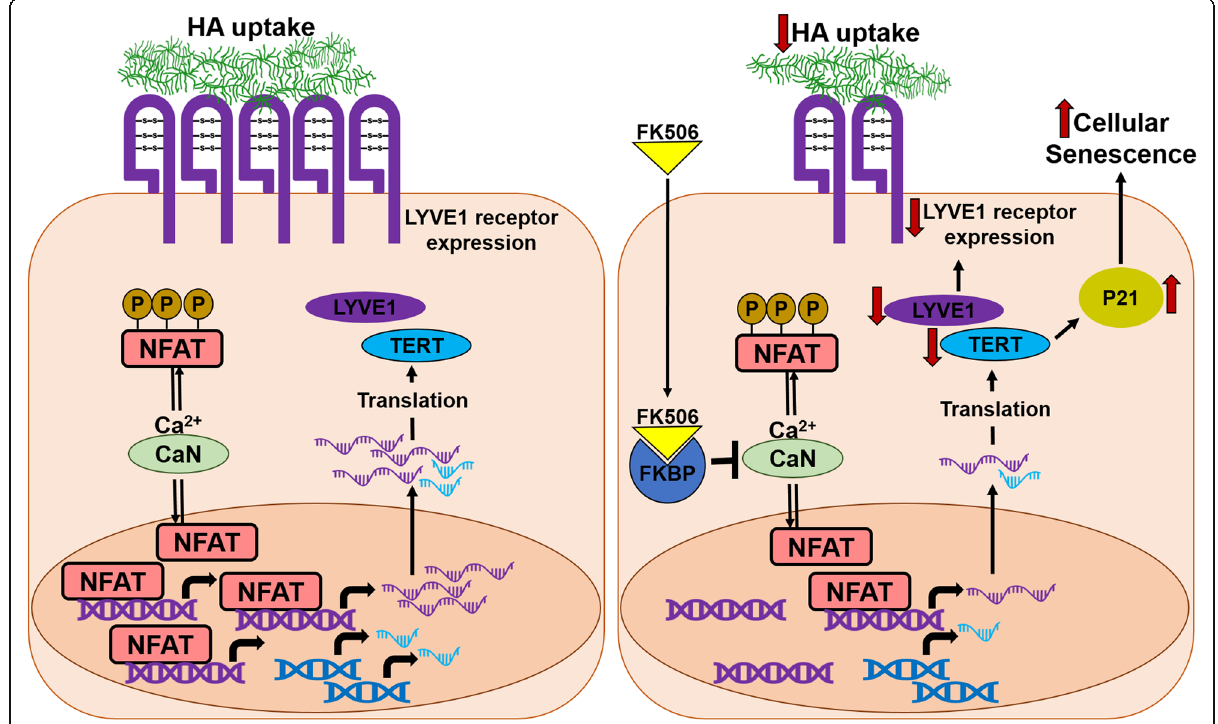
Fig. 7 Schematic representation of FK506-induced lymphatic dysfunction. Calcineurin dephosphorylates NFAT proteins and induces translocation of NFAT into the nucleus (Hogan et al., 2003). This leads to increased transcription of NFAT target gene. Our study demonstrated that LYVE-1 is one of the target gene regulated by NFAT. This increases LVYE-1 receptor expression in lymphatic endothelial cells (LEC), where LYVE-1 plays an important role in HA-uptake and clearance. In LEC in vitro, FK506, a calcineurin inhibitor, prevents the nuclear translocation of NFAT, resulting in reduced LYVE-1 expression and, consequently, reduction in HA uptake. Additionally, FK506 treatment also reduces TERT expression, which results increased cellular senescence implicated by increased P21 expression in